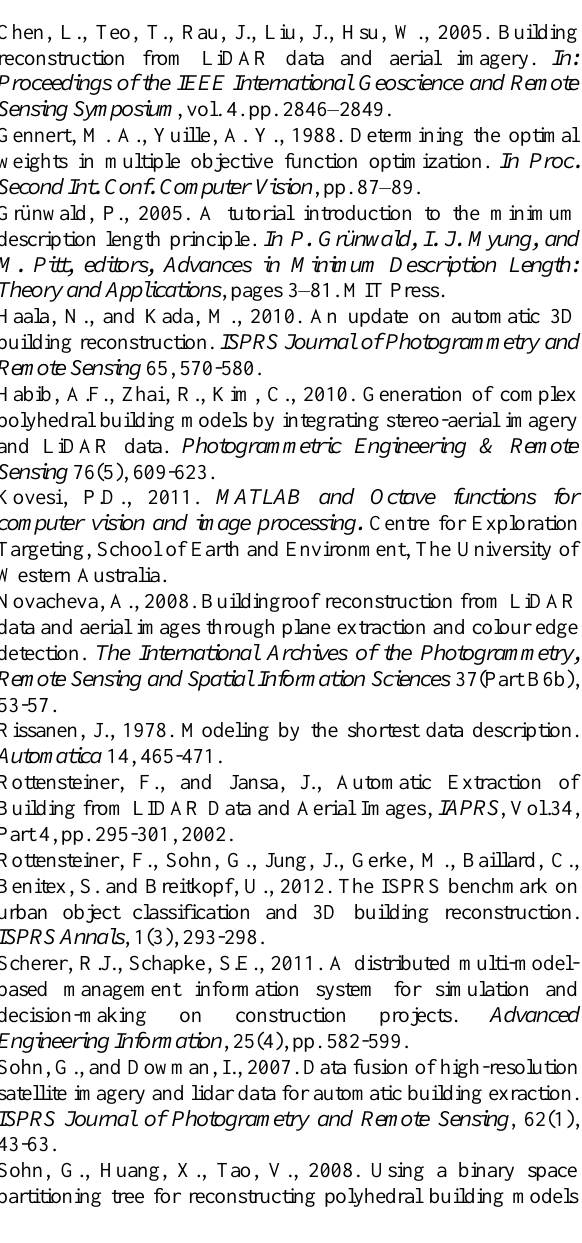
Figure 9. (a) Sum of area, perimeter, and the number of vertex of 7 test building models, respectively, (b) rate of increase of 7 test building models.